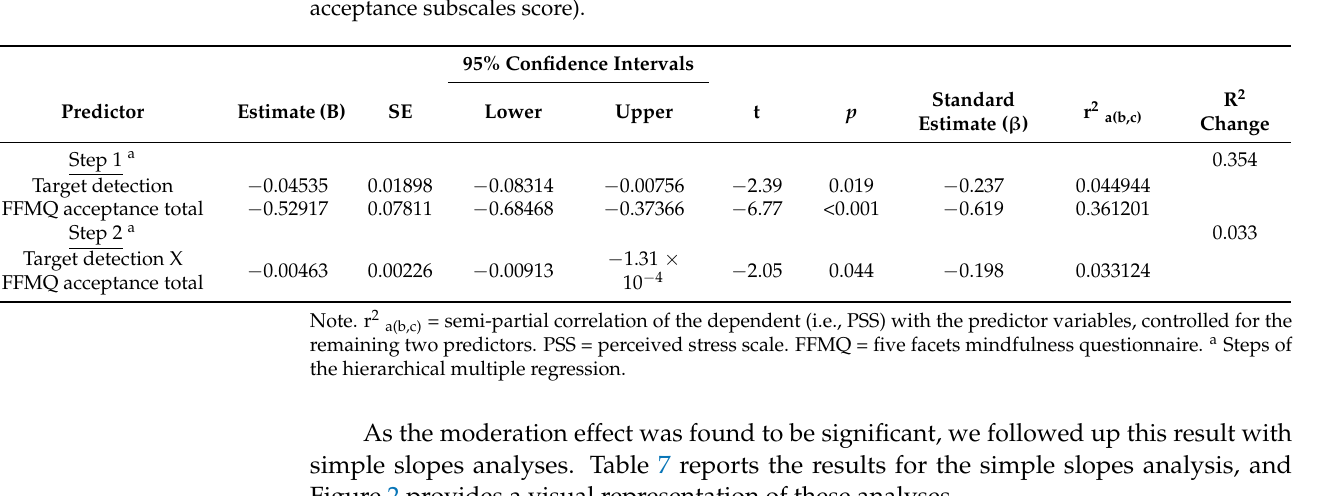
Table 6. Moderation model results for the prediction of Chronic Stress (i.e., PSS score) from Tar- get detection (i.e., orienting coefficient) moderated by Acceptance (i.e., combination of the FFMQ acceptance subscales score).